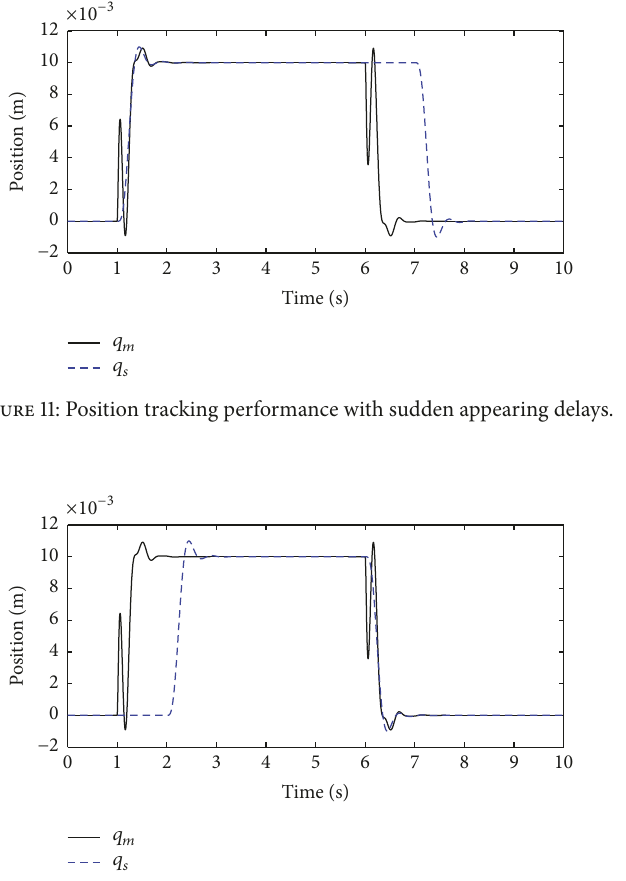
Figure 12: Position tracking performance with sudden disappearing